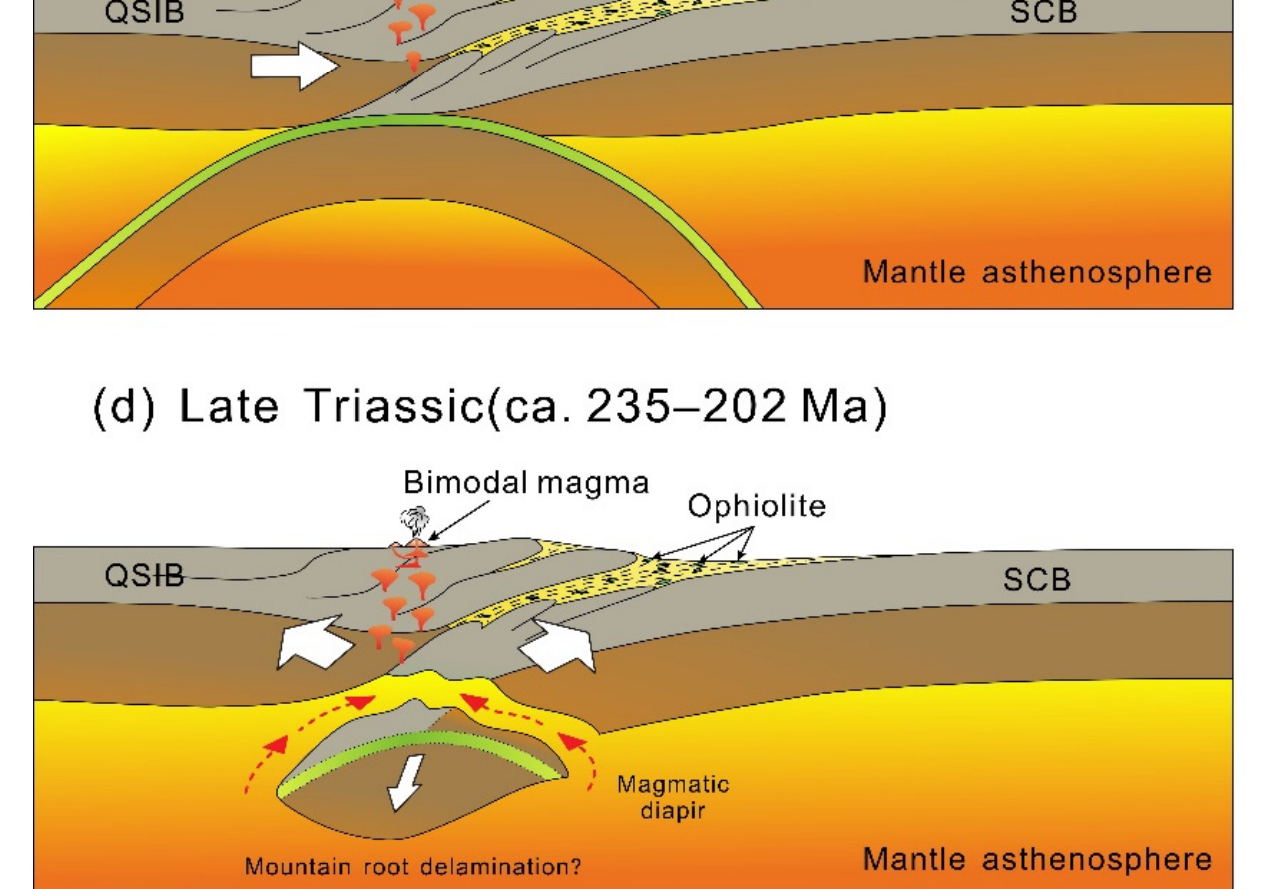
Figure 12. Schematic model illustrating the development of the JASB during the Early Permian to Late Triassic.( a ) During the Early Permian period (ca. 288–272 Ma), the JASO subducted westward under the QSIB and formed a continental margin arc along the JYTA; ( b ) During Middle Permian to Early Triassic (ca. 272–265 Ma), continuous subduction and slab rollback resulted in overriding plate extension to open a back-arc basin in the Batang-Yaxuanqiao area and to form Middle Permian MORB-like magmatic rocks. Meanwhile, subduction-associated magmatism that resulted from the eastward subduction of the JASO may have occurred on the southwestern margin of the SCB. ( c ) During the Middle Triassic (ca. 248–237 Ma), the collision between the QSIB and SCB closed the JASO and produced an intense orogenic magma in the JASB; ( d ) During the Late Triassic (ca. 235–202 Ma), the postcollisional extension along the JASB led to the MP metamorphic event and bi-modal